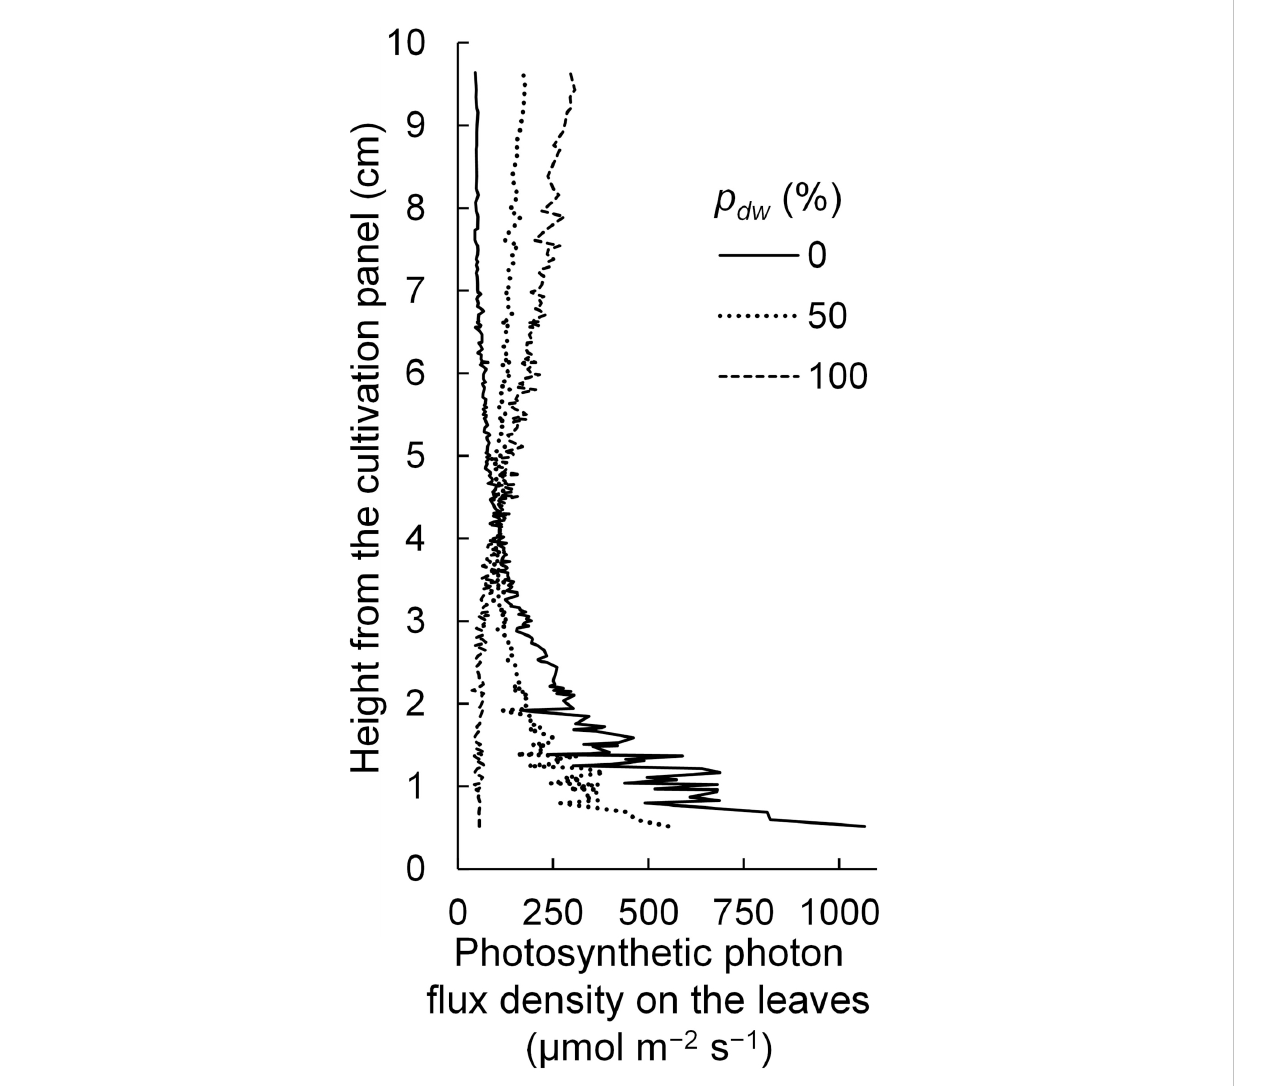
FIGURE 12 The vertical distribution of photosynthetic photon fl ux densities on the komatsuna leaves under different conditions, with the proportion ( p dw ) of the photosynthetic photon fl ux of lamps for downward lighting to that of whole lamps for downward and upward lighting ( F lamps ). The leaf area index and F lamps were 2.5 and 244 µmol s − 1 ,